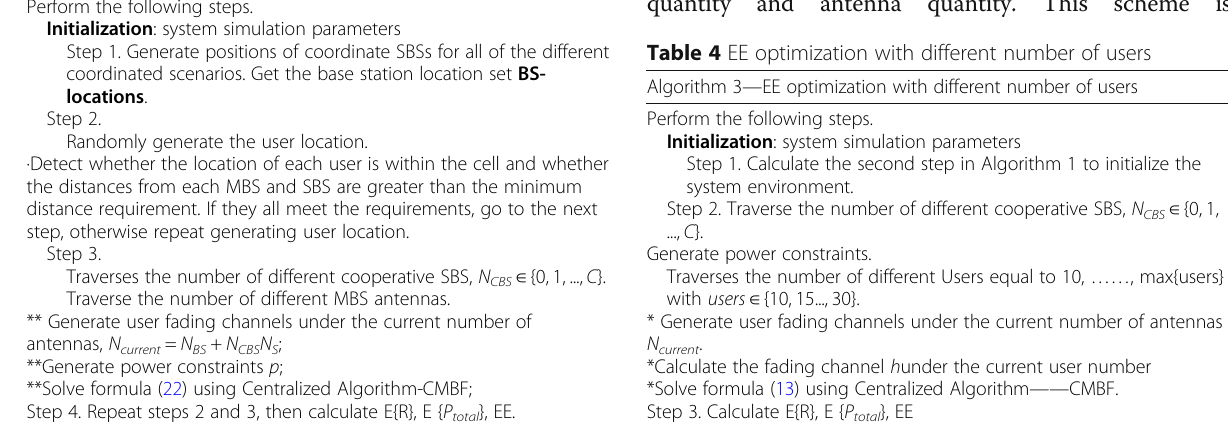
Table 2 EE optimization with different number of antennas Algorithm 1 — EE optimization with different number of antennas Perform the following steps. Initialization : system simulation parameters